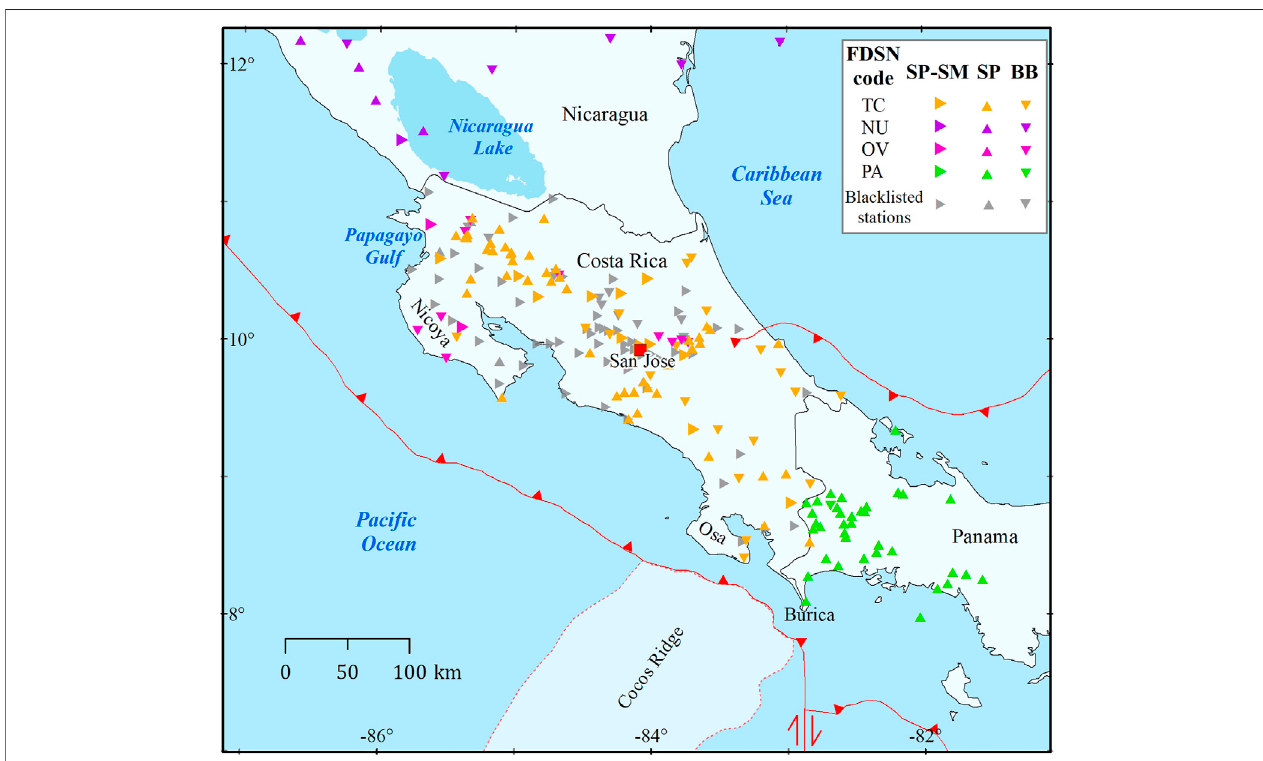
FIGURE 2 | Seismic stations used in this study. BB are broadband sensors, SP are short-period geophones, and SP-SM are short period and strong motion sensors. The stations are differentiated by FDSN (International Federation of Digital Seismograph Network) web services: TC, Red Sismológica Nacional de Costa Rica (light grey); NU, Nicaraguan Seismic Network (light blue); OV, Observatorio Vulcanológico y Sismológico de Costa Rica (light red); and PA, ChiriNet, Panama (orange). The blacklisted stations are represented in black color.